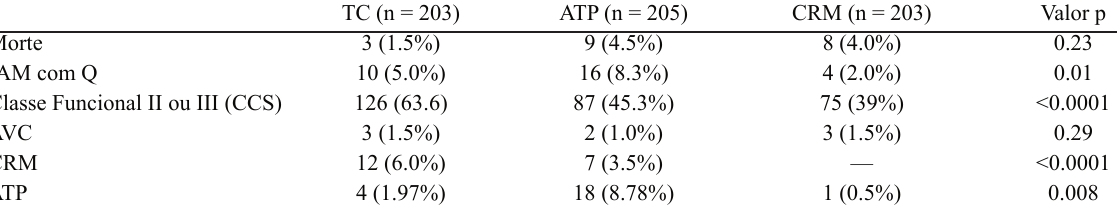
AVC - Acidente Vascular Cerebral. CCS - Canadian Cardiovascular Society. IAM – Infarto Agudo do